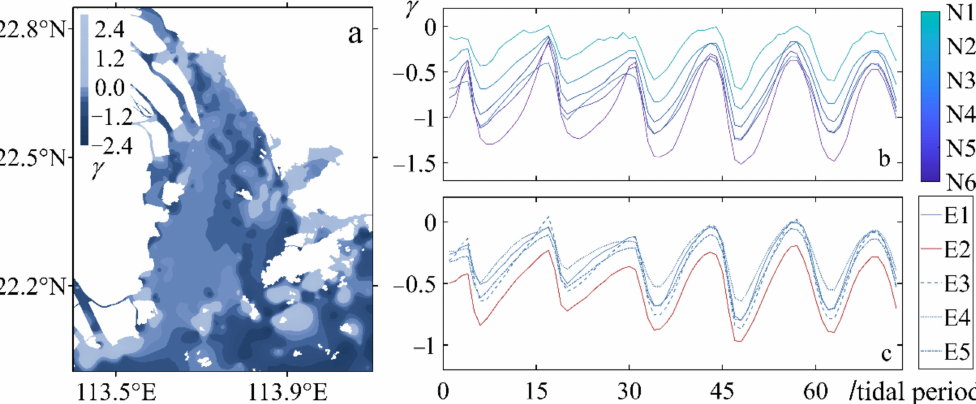
Figure 6. Spatio-temporal variations of FVA in LDB: ( a ) spatial variation of FVA, the color bar indicates the value of skewness; ( b , c ) time series of FVA of the selected stations (Figure 1d,e); the legend and the color bar correspond to the selected stations.